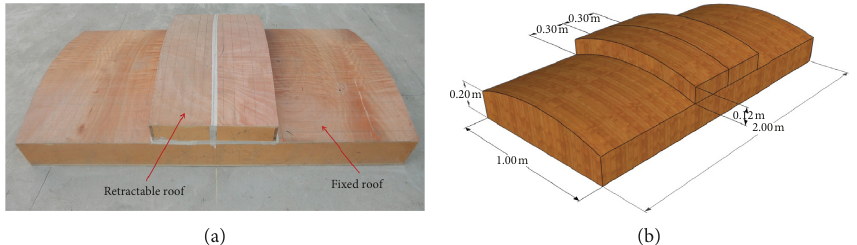
Figure 5: Schematic of size and shape of the test model. (a) Photograph of the test model. (b) “Closed”